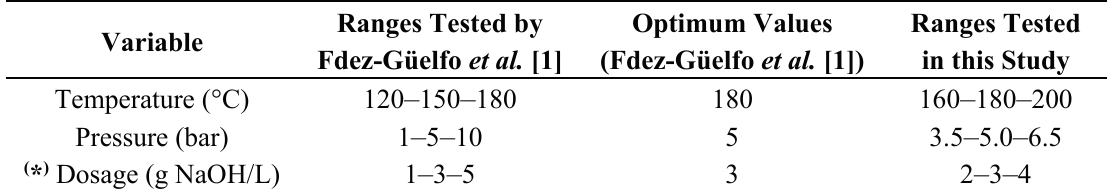
Table 5. Design of